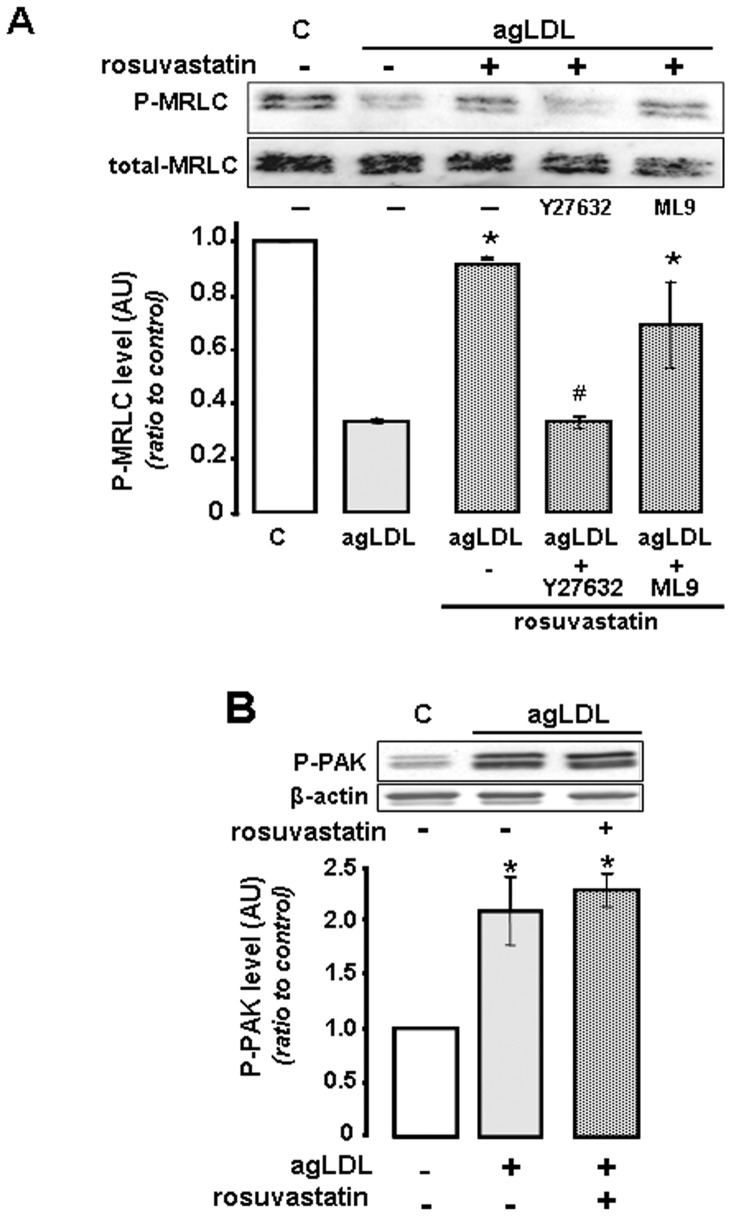
Rosuvastatin induced MRLC-phosphorylation in agLDL-VSMC is dependent on the activity of the RhoA/ROCK signaling pathway.VSMC incubated without/with agLDL, in the absence/presence of rosuvastatin analyzed by western blot for (A) P-MRLC in agLDL-VSMC incubated with rosuvastatin in the absence/presence of inhibitors for MLC-Phosphatase (Y27632) and MLCK (ML9). Bar diagram expresses mean±SEM of 3 independent experiments. *P<0.05 (Mann Whitney test) vs agLDL. # P<0.05 (Mann Whitney test) vs agLDL+rosuvastatin group. (B) phosphorylated PAK (p21-activated kinase) levels in VSMC exposed to agLDL in the absence/presence of rosuvastatin. Bar diagram represent the mean±SEM of 3 independent experiments. P<0.05 (Mann Whitney test), * vs control group.